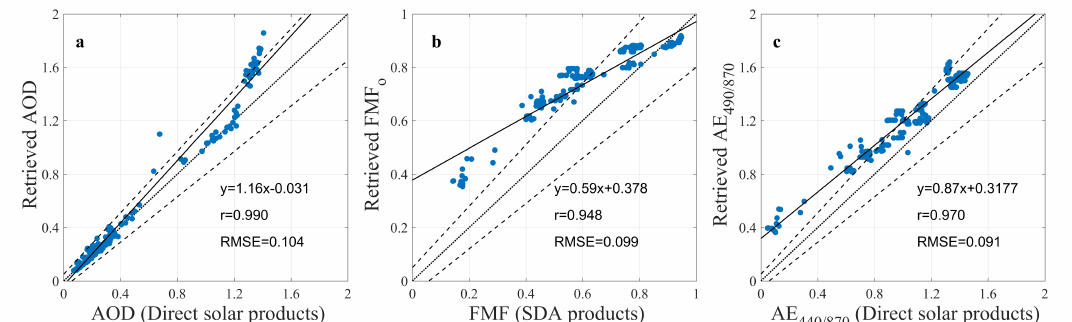
Figure 7. The scatter plot of retrieved ( a ) AOD at 500 nm, ( b ) FMF o at 500 nm, and ( c ) Ångström Exponent compared to the AERONET direct solar products. The solid line, dotted line, and dashed line represent the fit line, 1:1 line, and the expected error line ( ∆ x = ± 0.05 ± 0.15 x ),